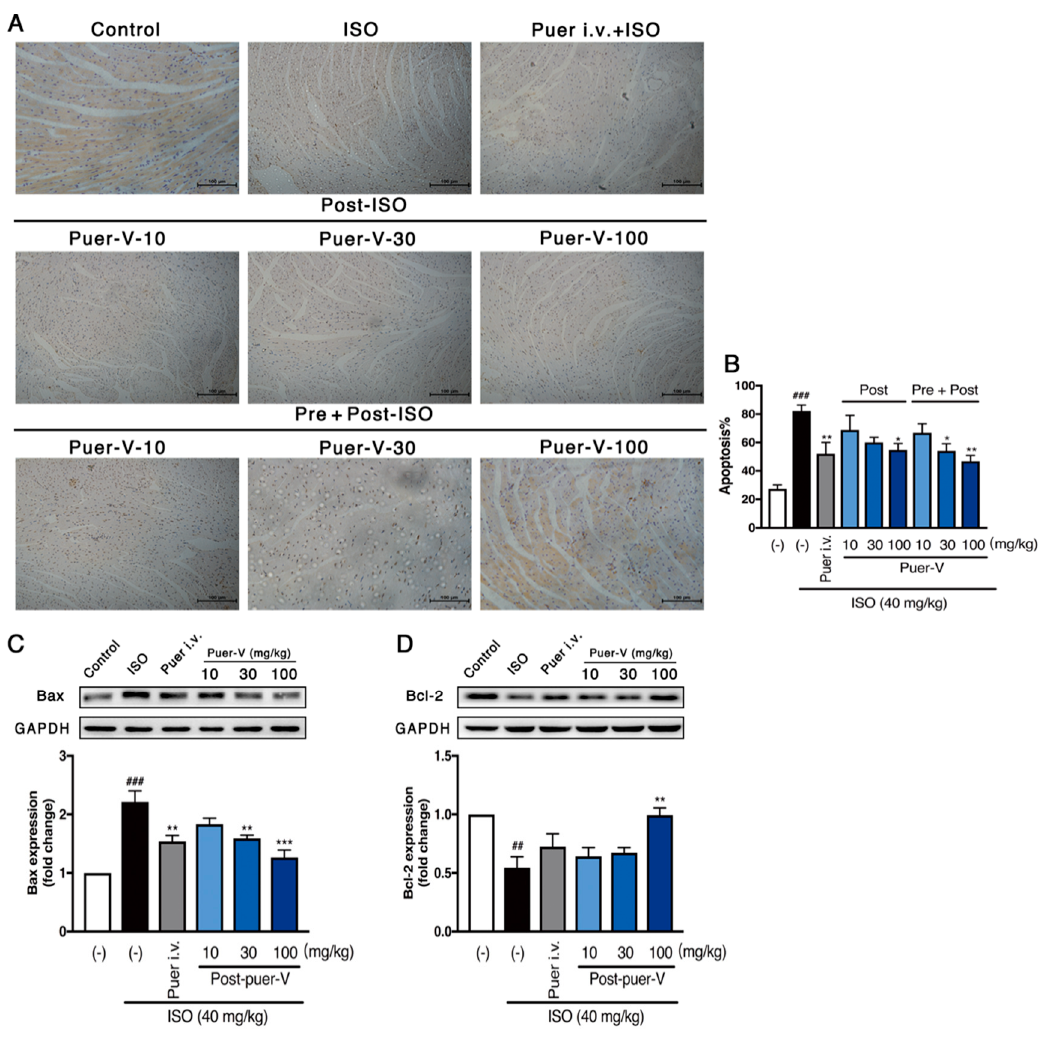
Figure 5. Puerarin-V inhibited ISO-induced apoptosis in the heart of MI mice. ( A ) The TUNEL-positive cells were shown by the immunohistochemistry method. The original magnification of the images was 200×. The scale bar is 100 μ m. ( B ) The percent of TUNEL-positive cells ( n = 4). ( C , D ) Western blot analyses for Bax and Bcl-2 expression, and normalization of these two expression by the expression of glyceraldehyde-3-phosphate dehydrogenase (GAPDH) ( n = 6). Data are shown as mean ± SEM. ## p < 0.01, and ### p < 0.001 vs. control group. ** p < 0.01, and *** p < 0.001 vs. model group.